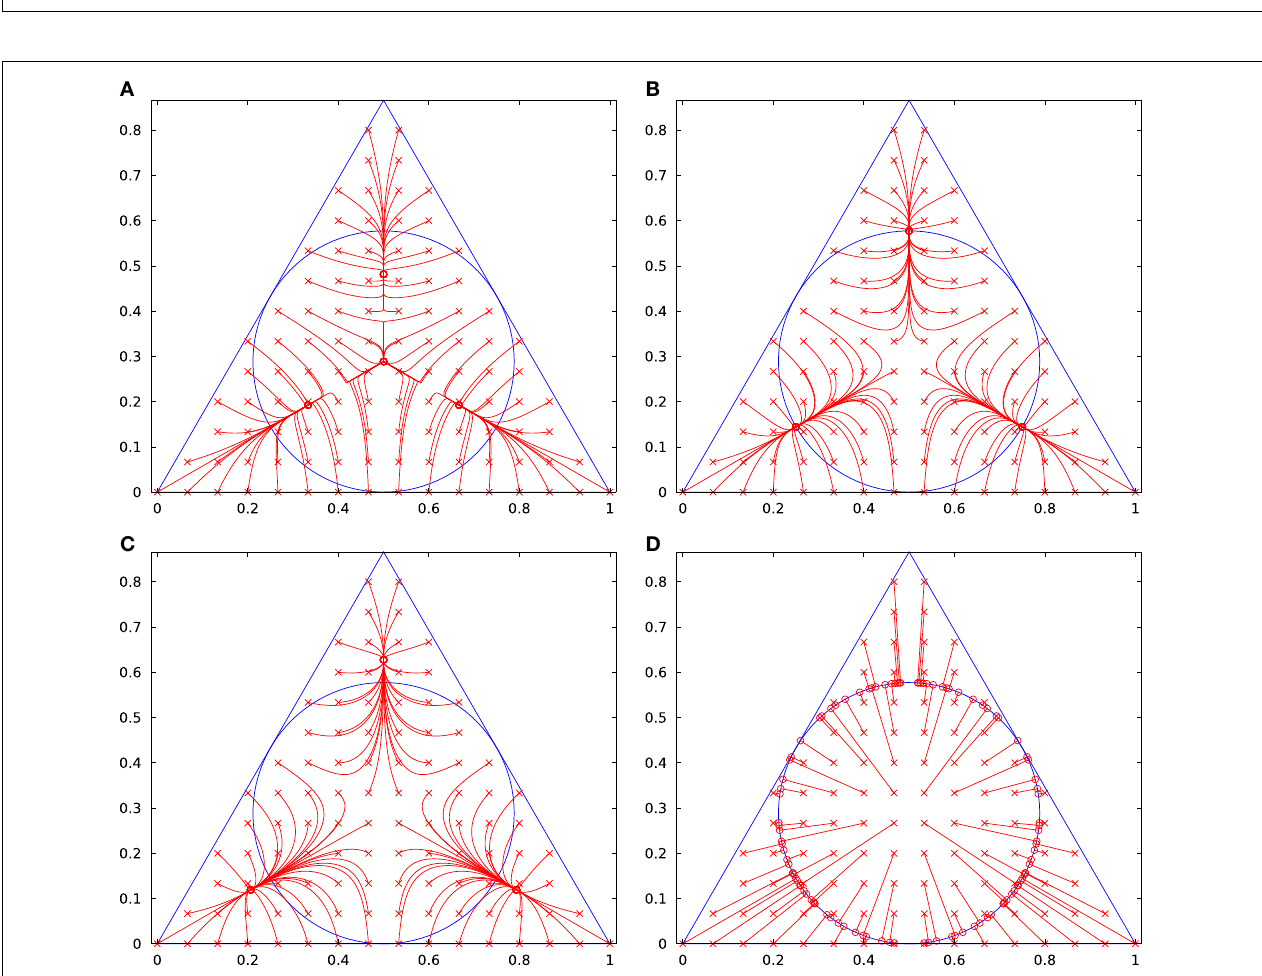
FIGURE 8 | Three-channel iterative processing . The original samples are indicated by crosses, the convergence points by circles. The results of Denève’s iterative method are shown in (A) ( (cid:12)(cid:12)(cid:12) === 0.26 (cid:11)(cid:11)(cid:11) ), (B) ( (cid:12)(cid:12)(cid:12) === 0.25 (cid:11)(cid:11)(cid:11) ), and (C) ( (cid:12)(cid:12)(cid:12) === 0.24 (cid:11)(cid:11)(cid:11) ). The result of our method (12) is shown in (D) .